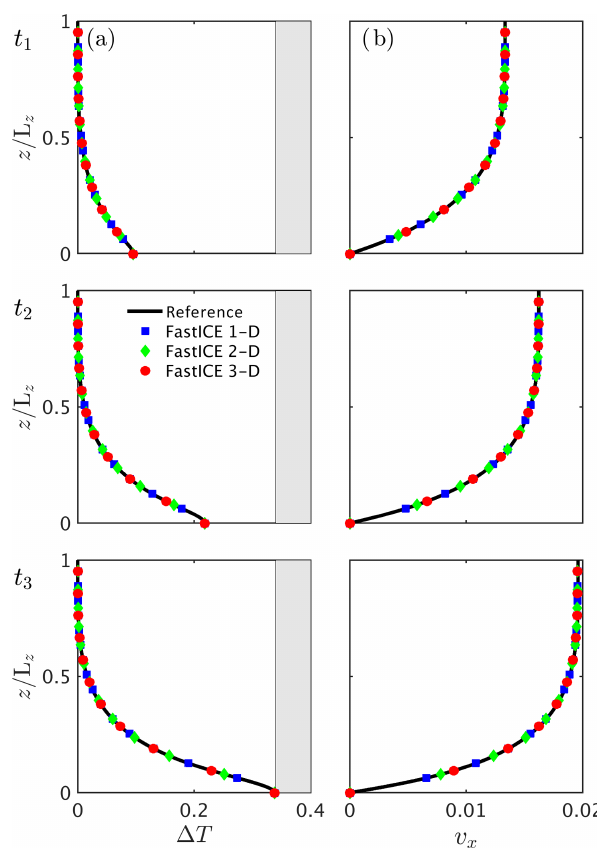
Figure 8. Non-dimensional simulation results for (a) the temper- ature deviation T and (b) the horizontal velocity component v x for the 1-D, 2-D and 3-D FastICE models at three different non- dimensional times 0 . 7 × 10 8 , 1 . 4 × 10 8 and 1 . 9 × 10 8 compared to the 1-D reference model results. We employ a vertical grid resolu- tion n z of 31 , 95 and 201 grid points. We sample the 1-D profiles at location x = L x / 2 in 2-D and at x = L x / 2 and y = L y / 2 in 3- D. The shaded areas correspond to the part of the solution that is above the melting temperature, since we do not account for phase transitions in this